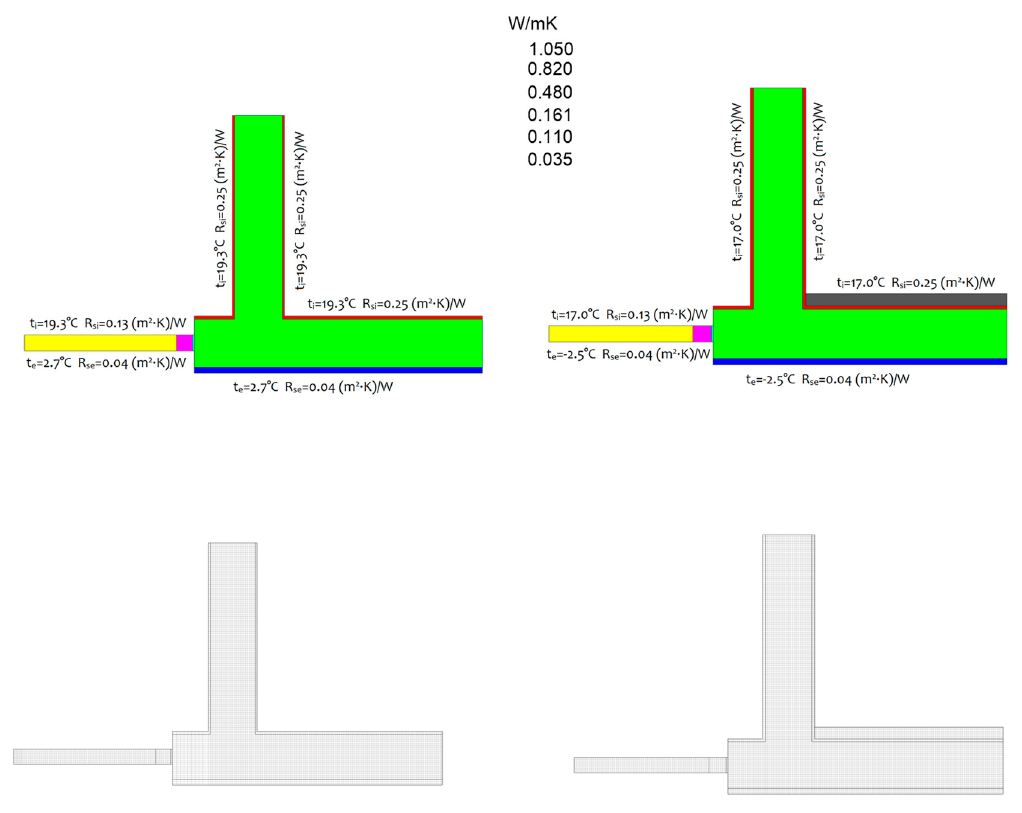
Figure 9. Boundary conditions and mesh compaction used in the modeling.